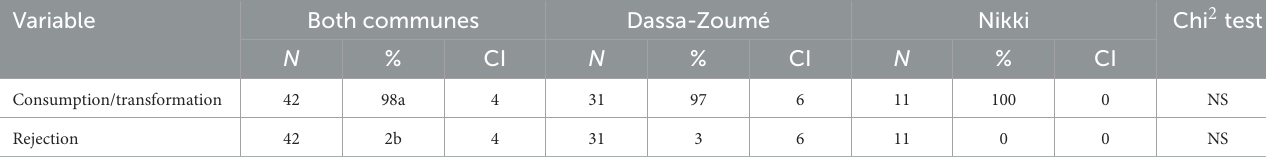
TABLE 4 Use of milk from cows treated with antibiotics without respecting the withdrawal period. Variable Both communes